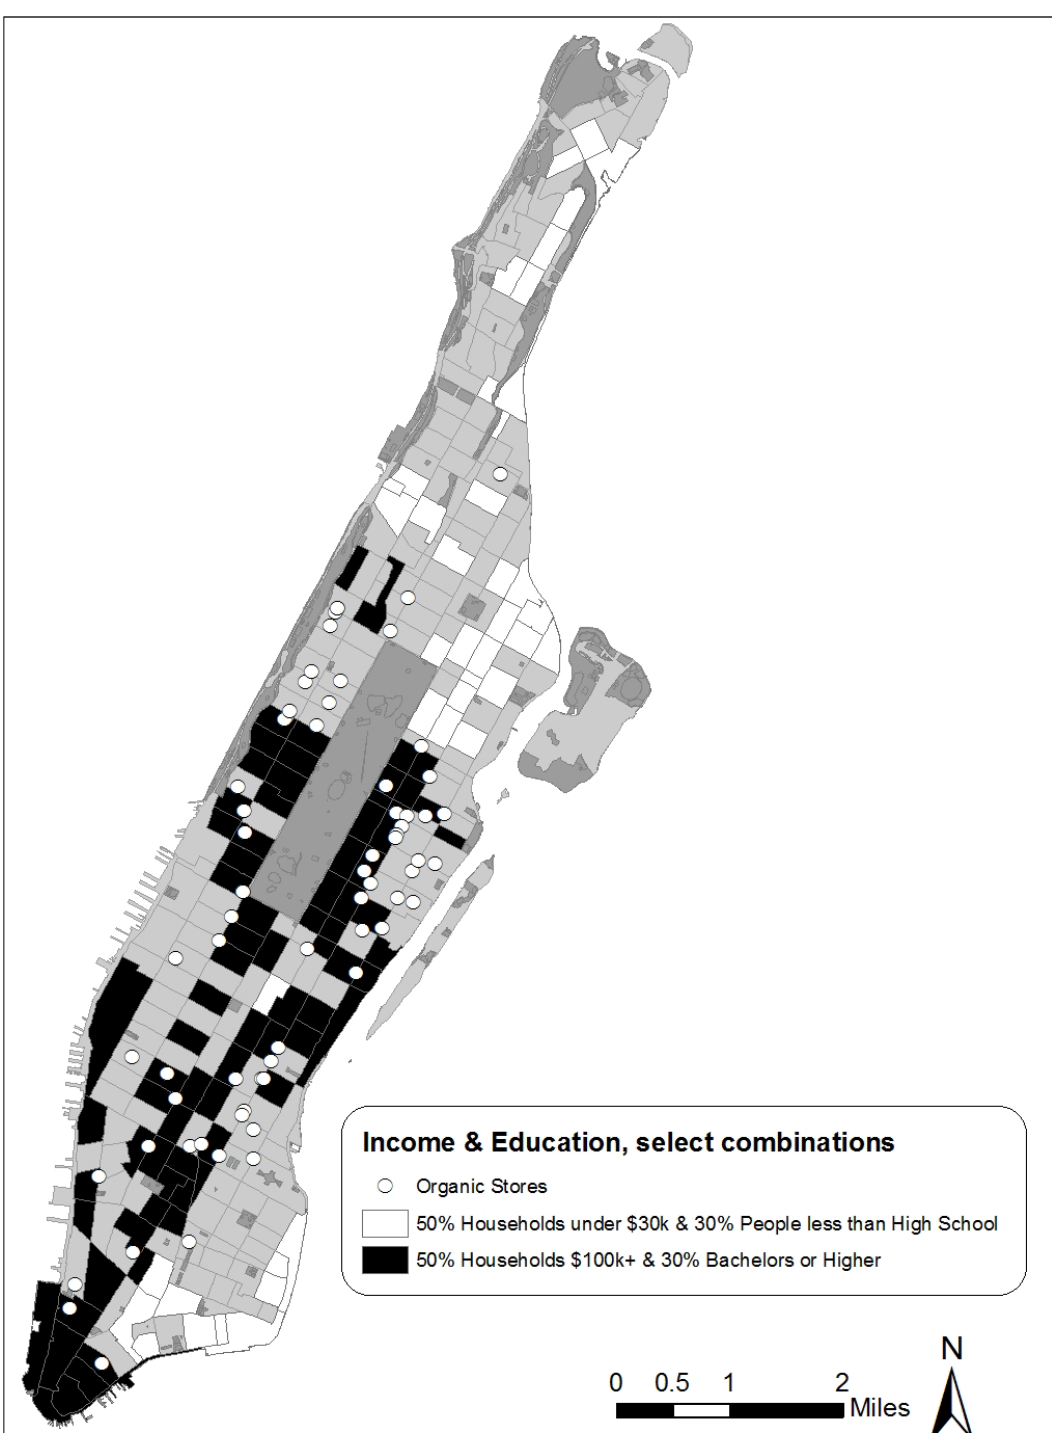
Figure 6. Organic Food Availability by Income and Educational Attainment,